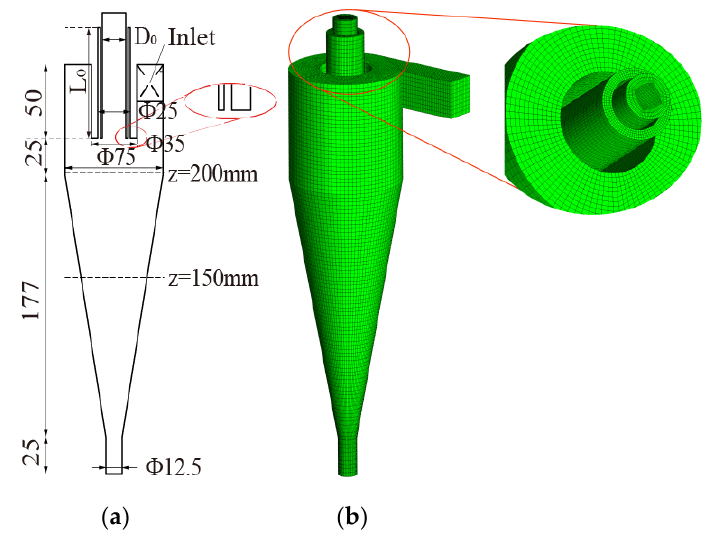
Figure 1. Hydrocyclone construction and meshing diagram. ( a ) Structure diagram. ( b ) Mesh.